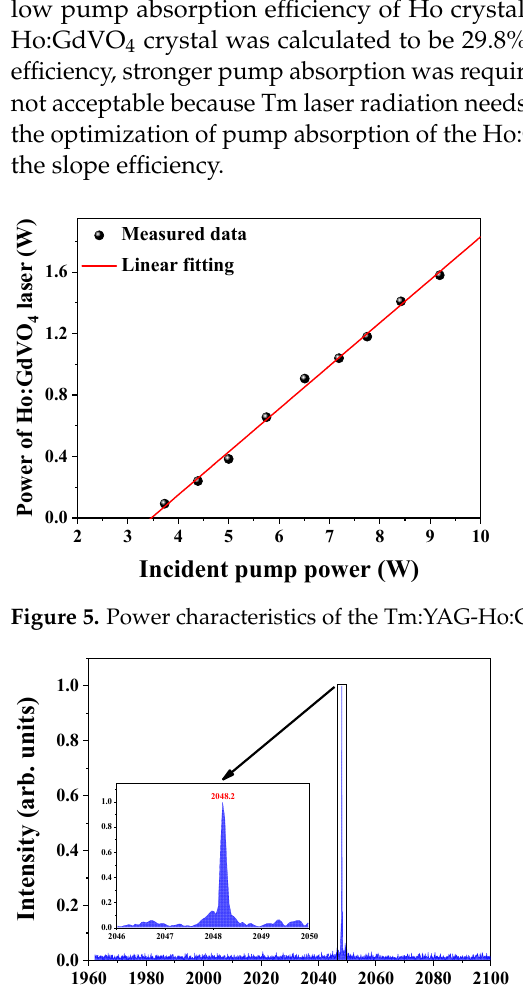
Figure 6. Spectrum of the Tm:YAG ‐ Ho:GdVO 4 laser. Measurement results of the M 2 of the intra-cavity Ho:GdVO 4 laser are shown in Figure 7. Under the strongest output of 1.6 W, M 2 factors could reach 1.06 ( x direction) and 1.03 ( y direction), which meant that the output laser beam was close to the diffraction limit.